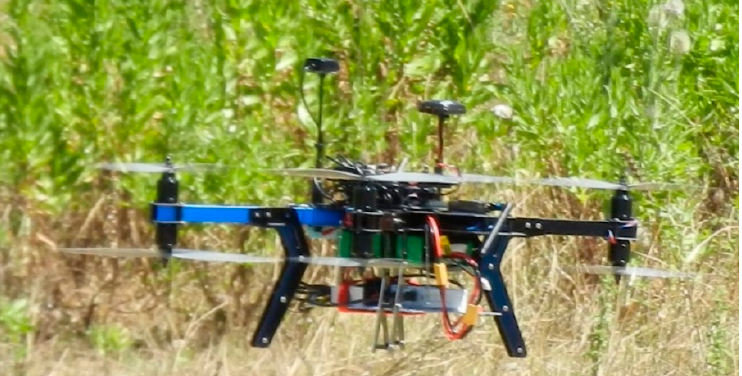
Figure 9. Customized X8 + by 3D Robotics used as flying deputy.